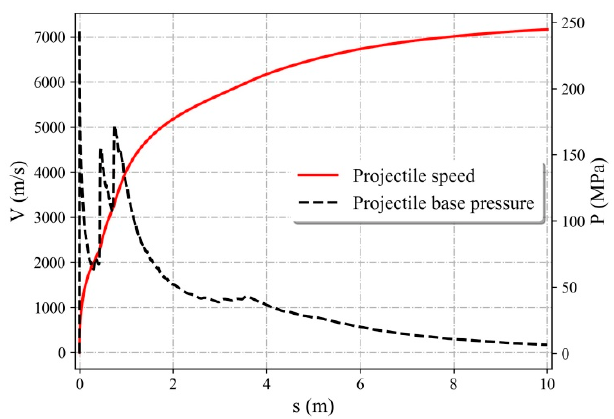
Figure 15. Projectile speed and base pressure for Case